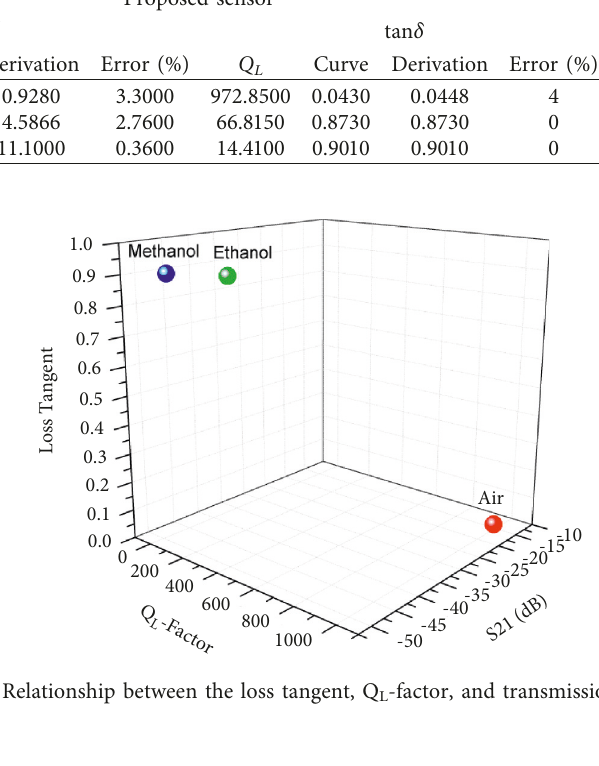
Proposed sensor